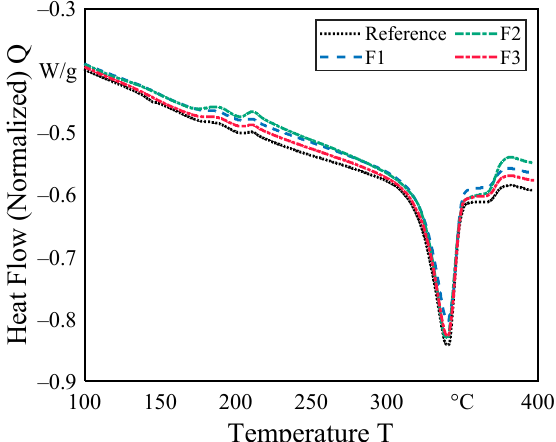
Figure 5. Representative Laser Scanning Microscopy (1200× magnification, height thresholded) of the cross-sectional area of the boundary interface of the PEEK/CF specimens. ( a ) Reference experiment. ( b ) F1 experiment. ( c ) F2 experiment. ( d ) F3 experiment. Table 3. Porosity level of PEEK/CF specimens manufactured by laser-based TAFP.